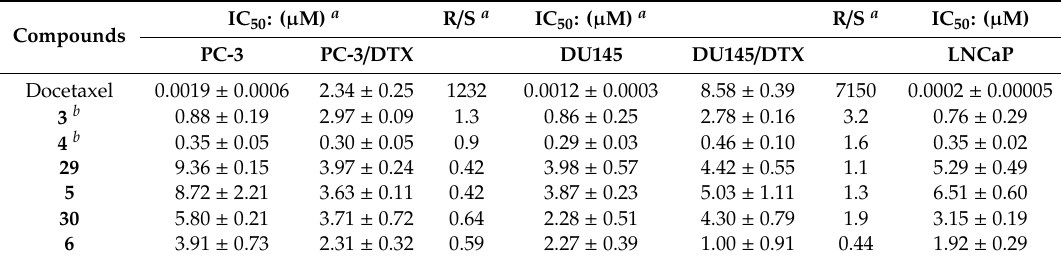
Table 1. Antiproliferative potency of zampanolide mimics against docetaxel-sensitive and docetaxel-resistant prostate cancer cells.